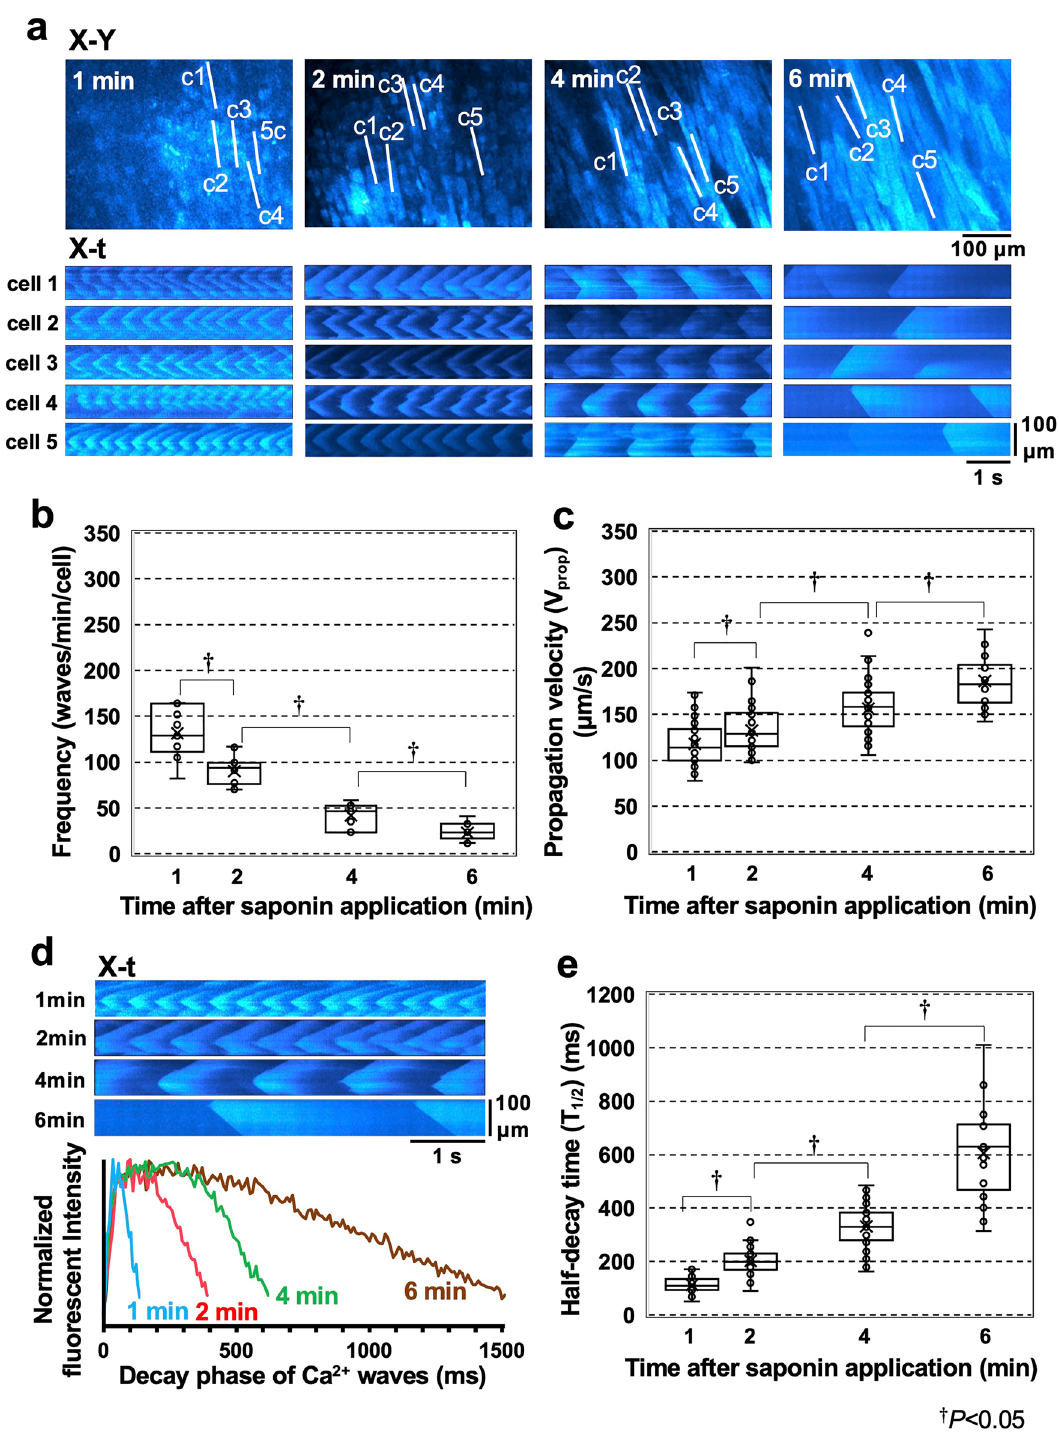
Figure 2. Sequential changes in the nature of the high-frequency Ca 2+ waves induced by saponin treatment. ( a ) X–Y images (upper panel) and corresponding X-t images (lower panel) for each of the five different cardiomyocytes (cells 1–5) scanned along the lines (c1–c5) identified in the X–Y images over a 6 min period. The sequential changes in the frequency ( b ) and propagation velocity (V prop ) ( c ) of the Ca 2+ waves in these cells are represented as box plots. ( d ) Representative X-t images for each of the Ca 2+ waves (upper panel) and the superimposed plot profiles of the wave decay patterns at 1, 2, 4, and 6 min after saponin treatment (lower panel). Each plot profile is shown as an averaged value of the profiles obtained from five different horizontal lines in each X-t image. ( e ) Sequential changes in the half-decay time (T 1/2 ) of the Ca 2+ waves. Statistical analyses were performed using the Kruskal ‒ Wallis test followed by the Steel ‒ Dwass test. † P <